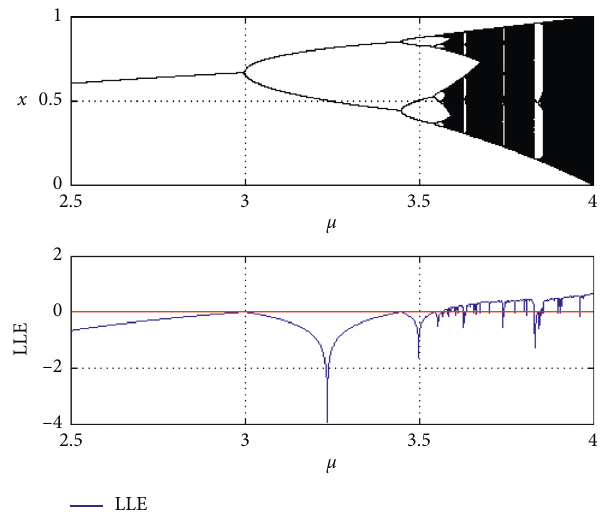
Figure 18: The logistic map and its largest Lyapunov